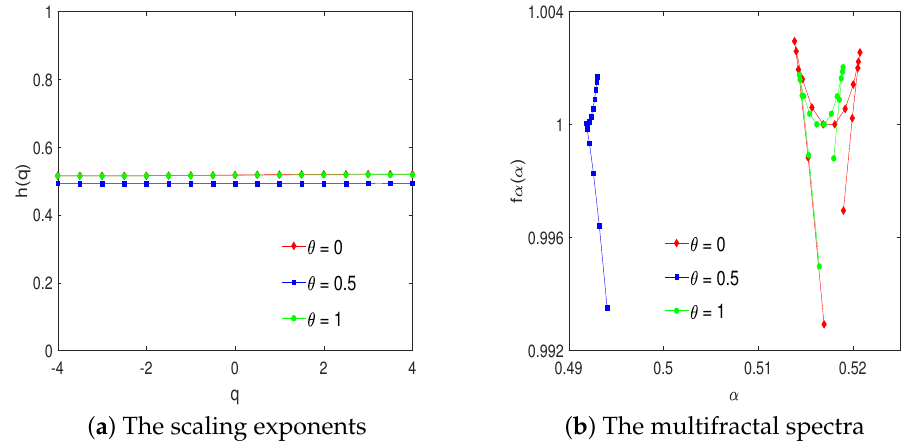
Figure 1. Uncorrelated monofractal series.